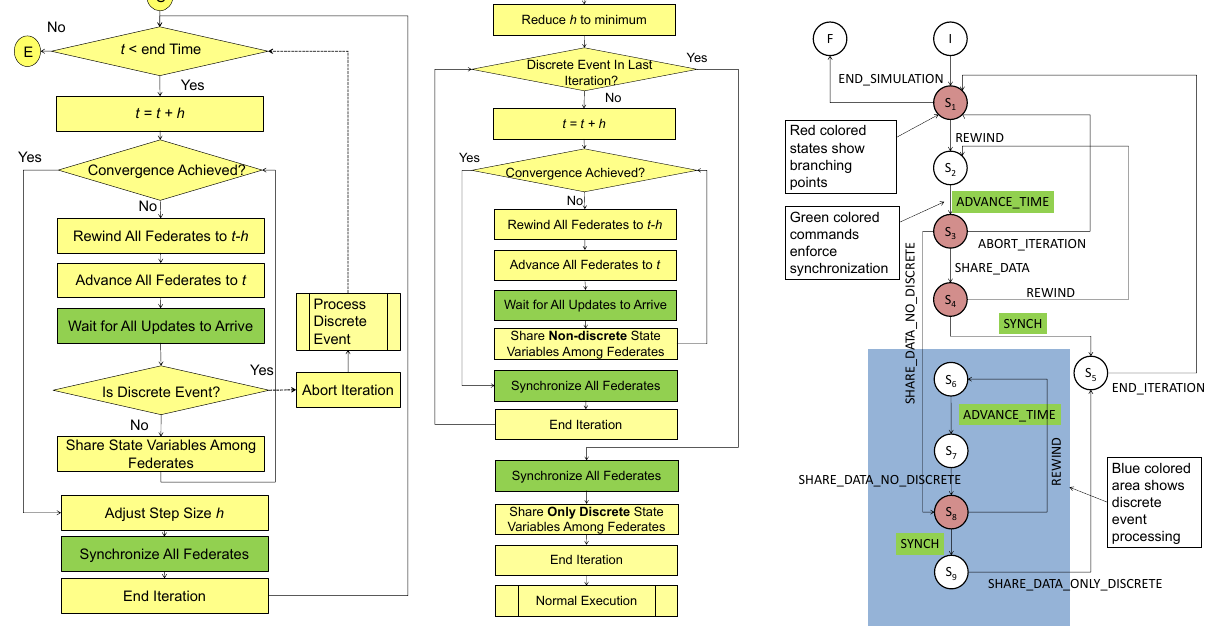
discrete event processing